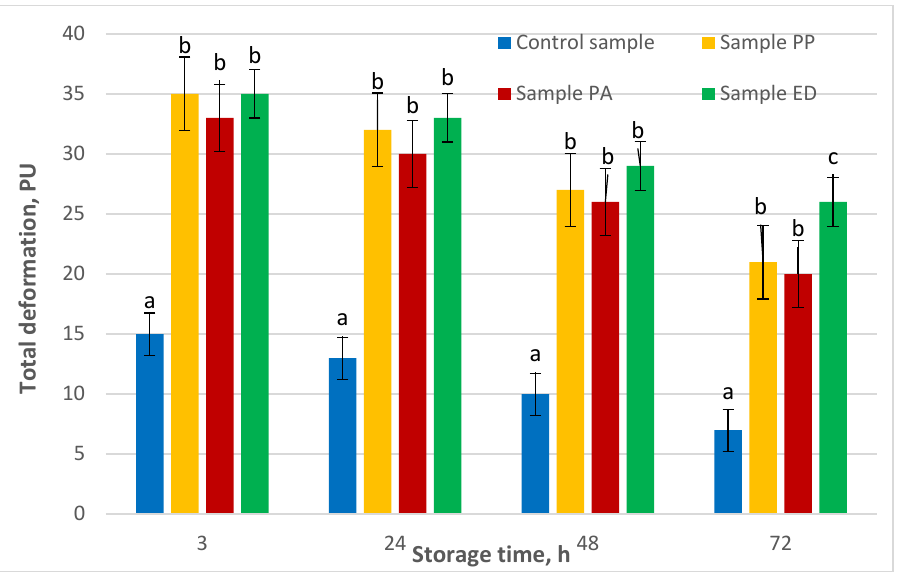
Figure 3. Effect of the different LAB strains on the total deformation of nongluten bread. Note: PU — penetrometric units; PA — sample with Pediococcus acidilactici 02P108; PP — sample with Pediococcus pentosaceus 12R2187; ED — sample with Enteroccocus durans 09B374. Different small letters for each time measurement indicate significant difference between mean values ( p < 0.01).